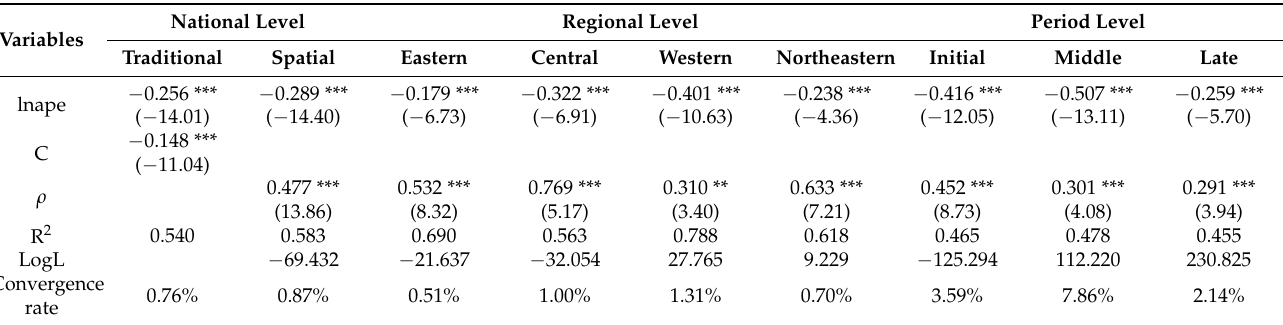
Table 4. Spatial β absolute convergence test of APE under the dual constraints of climate change and resource